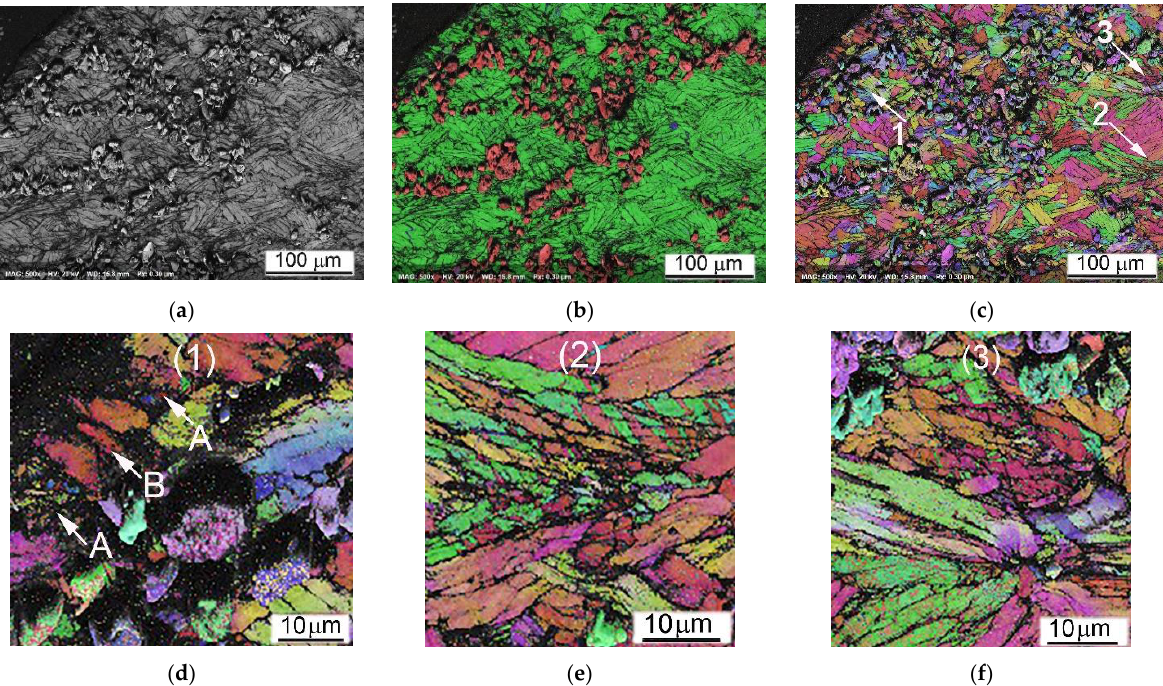
Figure 12. SEM EBSD images of the fractured composite Ti64BEPM + 10TiC after SHPB test with the rate 1640 s −1 . Pattern Quality Map ( a ) , phase map ( b ), and orientation map ( c – f ) images. The α-phase is shown in ( b ) using green, β-phase blue, and TiC red colors. All images are taken in vicinity of the Zone II (Figure 8); the images ( a – c ) centers are within 200 μm away from the place of fracture (main crack) visible in the left top corner of the images ( a – c ). The numbered areas in ( c ) are shown at higher magnification images: (1) in ( d ), (2) in ( e ) and (3) in ( f ).